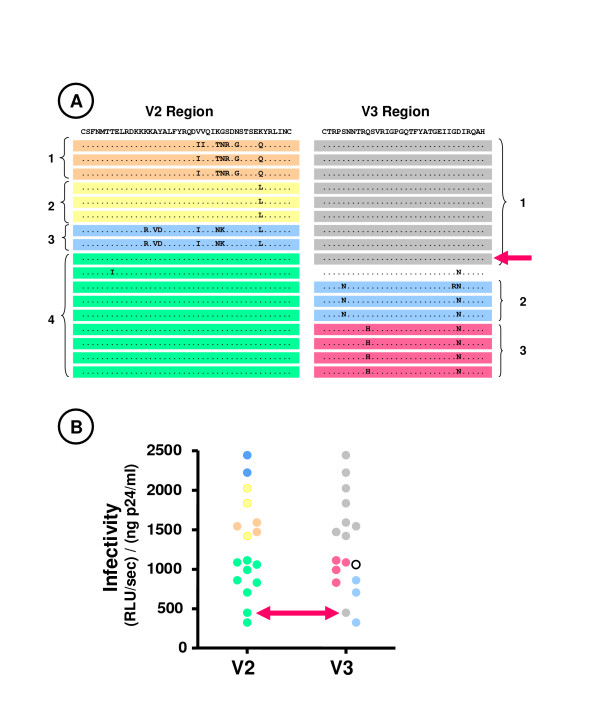
Expression of V2 and V3 region haplotypes in Env proteins of clonal viruses from patient 2 and viral infectivity. (A) The haplotypes in the V2 region (left) and V3 region (right) of the Env proteins expressed by the 17 clonal viruses from patient 2 with strict R5 tropism are shown. The consensus amino sequence is shown on the top line, and only amio acids differing from the consensus sequence are shown for each clone. For each variable region, sequences that are identical or that differ by a single amino acid substitution not identified in another sequence are highlighted by the same color, and these haplotypes are also identifed by numbers adjacent to the brackets. The red arrow indicates the envelope expressing the V2 region haplotype 4 associated with the V3 region haplotype 1 (see text). (B) The infectivity of recombinant viruses expressing these Env proteins using U373-R5 cells is shown. For each of the variable regions, the color of the symbols corresponds to that of the V region haplotype expressed by that virus. The red arrow indicates the infectivity of the clone expressing the V2 region haplotype 4 associated with the V3 region haplotype 1.